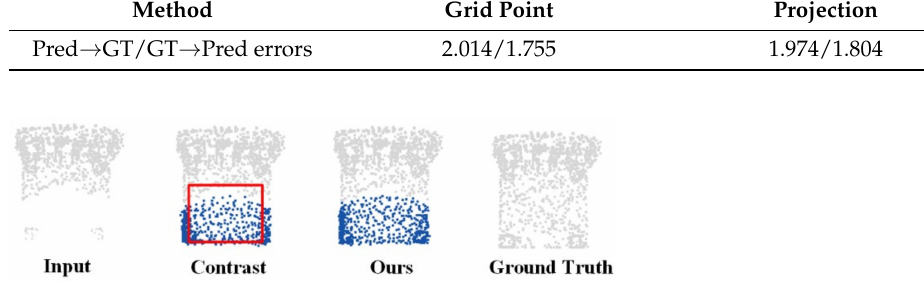
Figure 11. Comparison experiment of plane folding analysis.